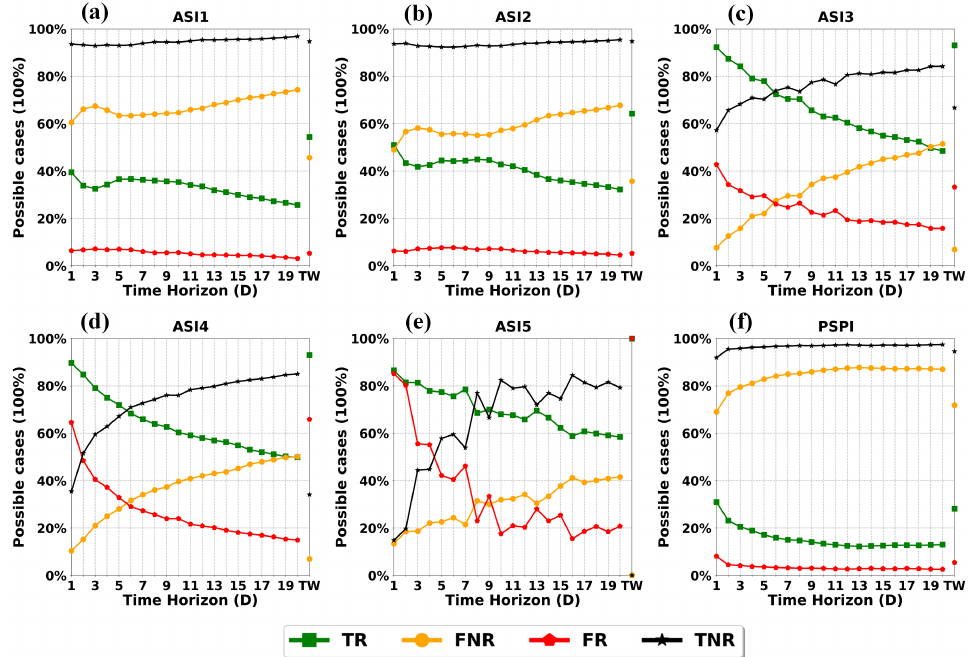
Figure 7. Variability of all predicted possible cases of Table 2 as well as at the 20-minute time window (TW) for ( a ) ASI1, ( b ) ASI2, ( c ) ASI3, ( d ) ASI4, ( e ) ASI5 and ( f ) PSPI. The time horizon begins from 1 min and reaches 20min in minute-by-minute increments. The percentages of each Table 2 quadrant are calculated based on the true measured cases (either for the ramp or no-ramp events). TR = True Ramp, FNR = False No-Ramp, FR = False Ramp and TNR = True